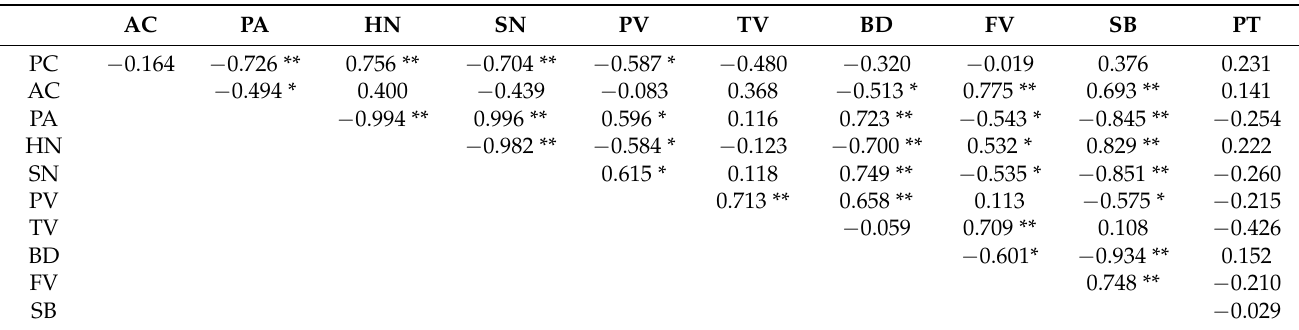
Table 5. Correlation matrix of the protein content, amylose content, eating quality and pasting properties (1) of japonica rice cultivars.